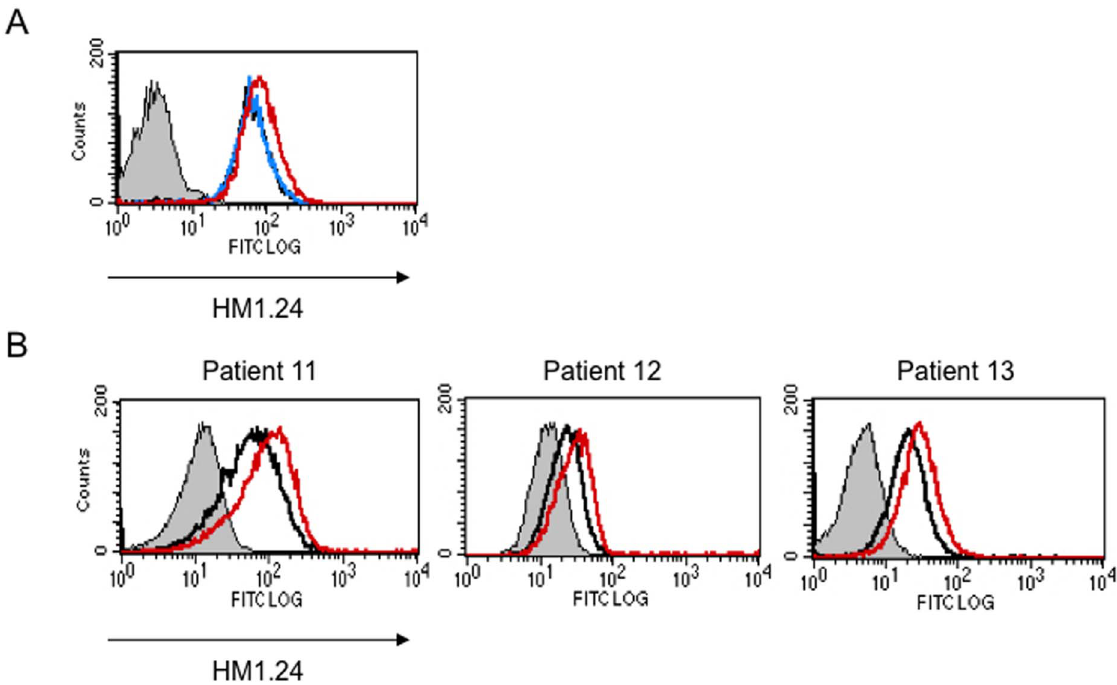
Figure 3. Len enhanced the HM1.24 expression on primary MM cells in the presence of effector cells. (A) RPMI 8226 cells were cultured for 48 hours in the absence (black) or presence of 3 m M Len alone (blue), or 3 m M Len plus PBMCs from a healthy donor using membrane filters to avoid cell contact (red). (B) BMMCs from MM patients (no. 11, 12, and 13) were cultured for 48 hours in the absence (black) or presence of 3 m M Len (red). Thereafter, the MM cells were stained with control FITC-labeled mouse IgG or FITC-labeled HM1.24 mAb, and PE-labeled CD38 mAb, and analyzed by flow cytometry. MM cells were gated according to a side scatter (SS) and CD38 expression, and analyzed for their HM1.24 expression.